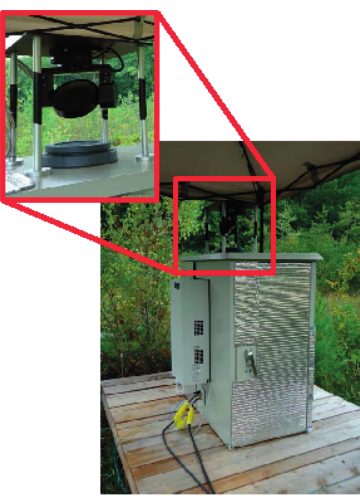
Figure 1. Chirped Laser Dispersion Spectroscopy (CLaDS) methane instrument installed in a weatherized enclosure; the inset shows a close-up of the optical port and a computer-controlled gimbal mount used to direct light horizontally to different sections of the fen.